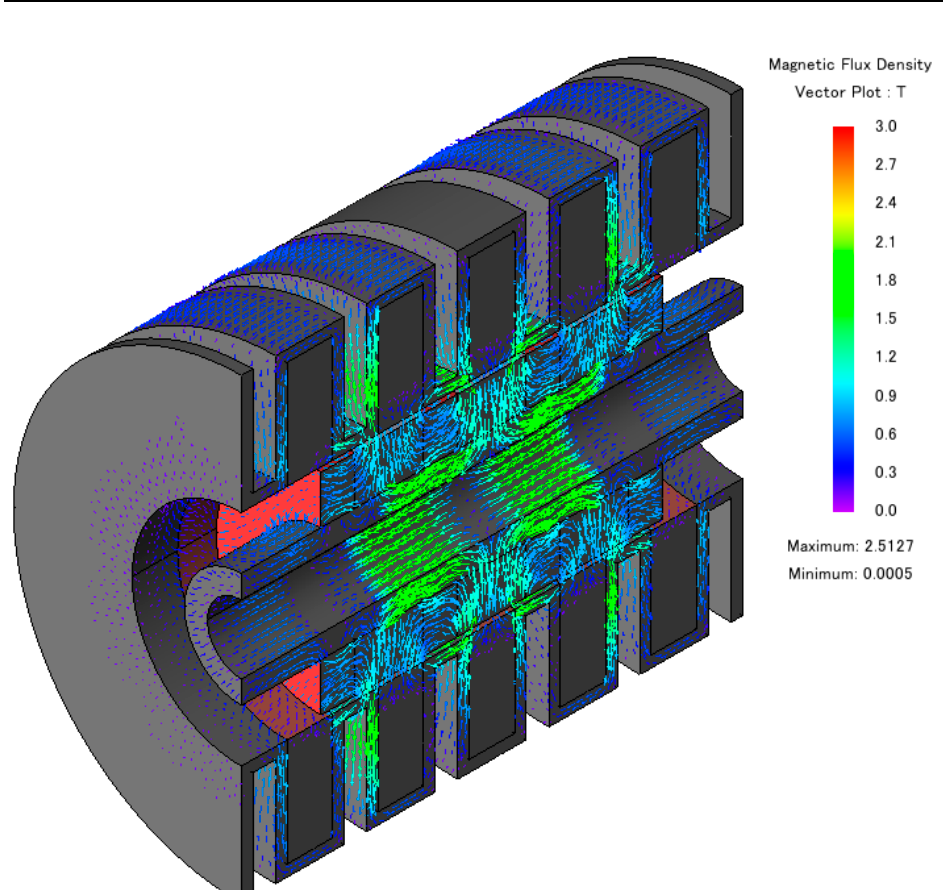
Figure 16. Magnetic flux density distribution of the modified model.